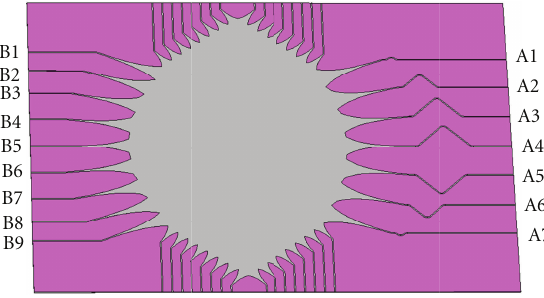
Figure 3: Simulation model of HPEM Rotman